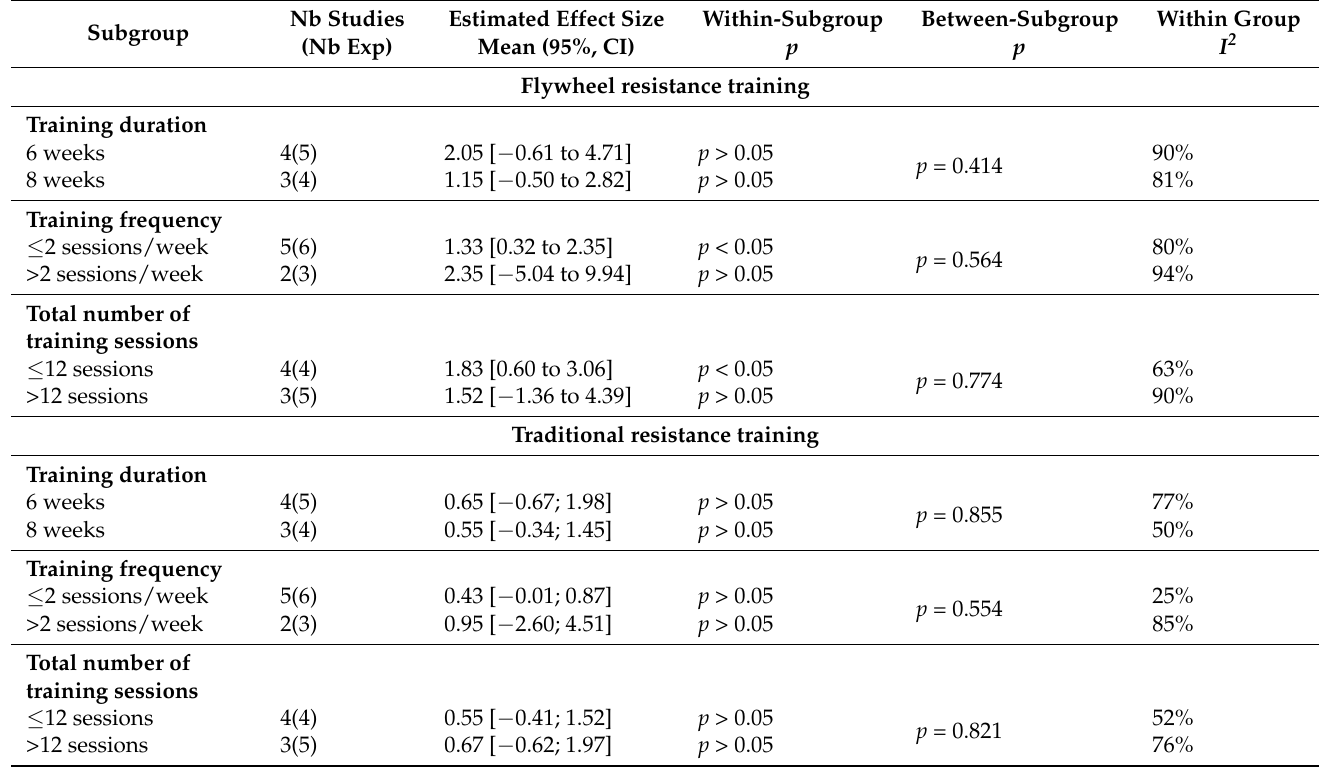
Table 4. Single training factor analyses for the flywheel and traditional resistance